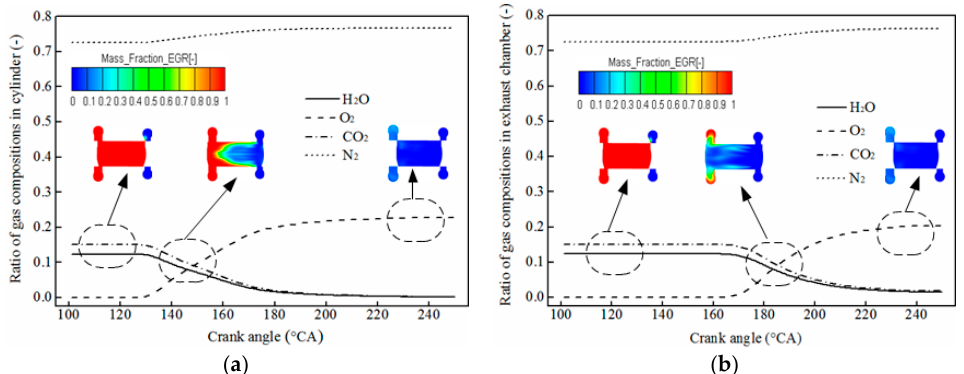
Figure 6. The variation of gas components in the scavenging process: ( a ) In-cylinder gas components; ( b ) Exhaust chamber gas components.